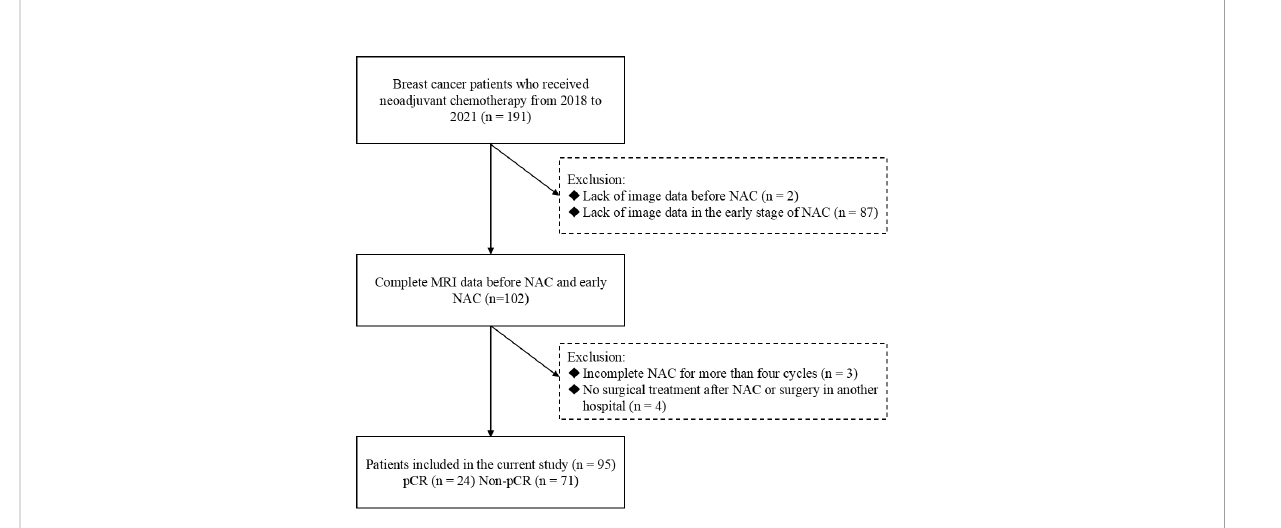
FIGURE 1 Flowchart of patient enrollment in the